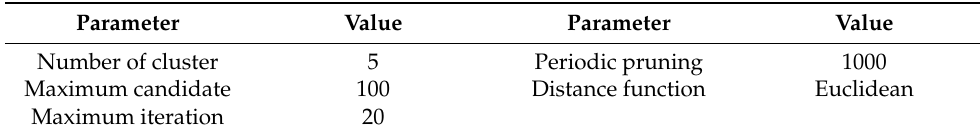
Table 2. K-Means cluster applied for water